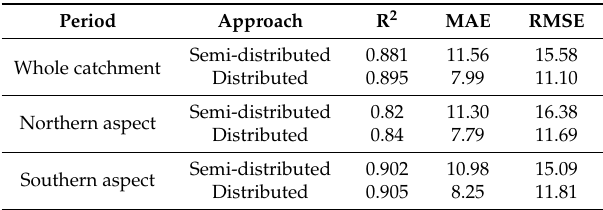
Table 5. RMSE, MAE and R 2 values for the observed and simulated SCA (based on the distributed and semi-distributed approaches) for 2011–2013 time period for the whole catchment, Northern aspect (N, NE, NW) and Southern aspect (S, SE, SW).